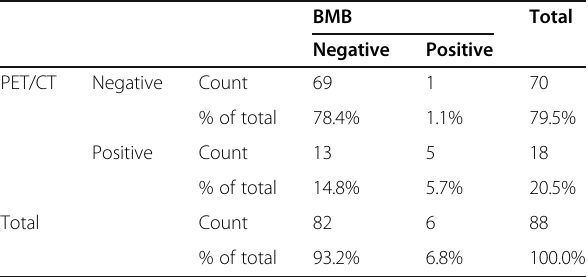
Table 9 Agreement between PET/CT and BMB in HD lymphoma cases